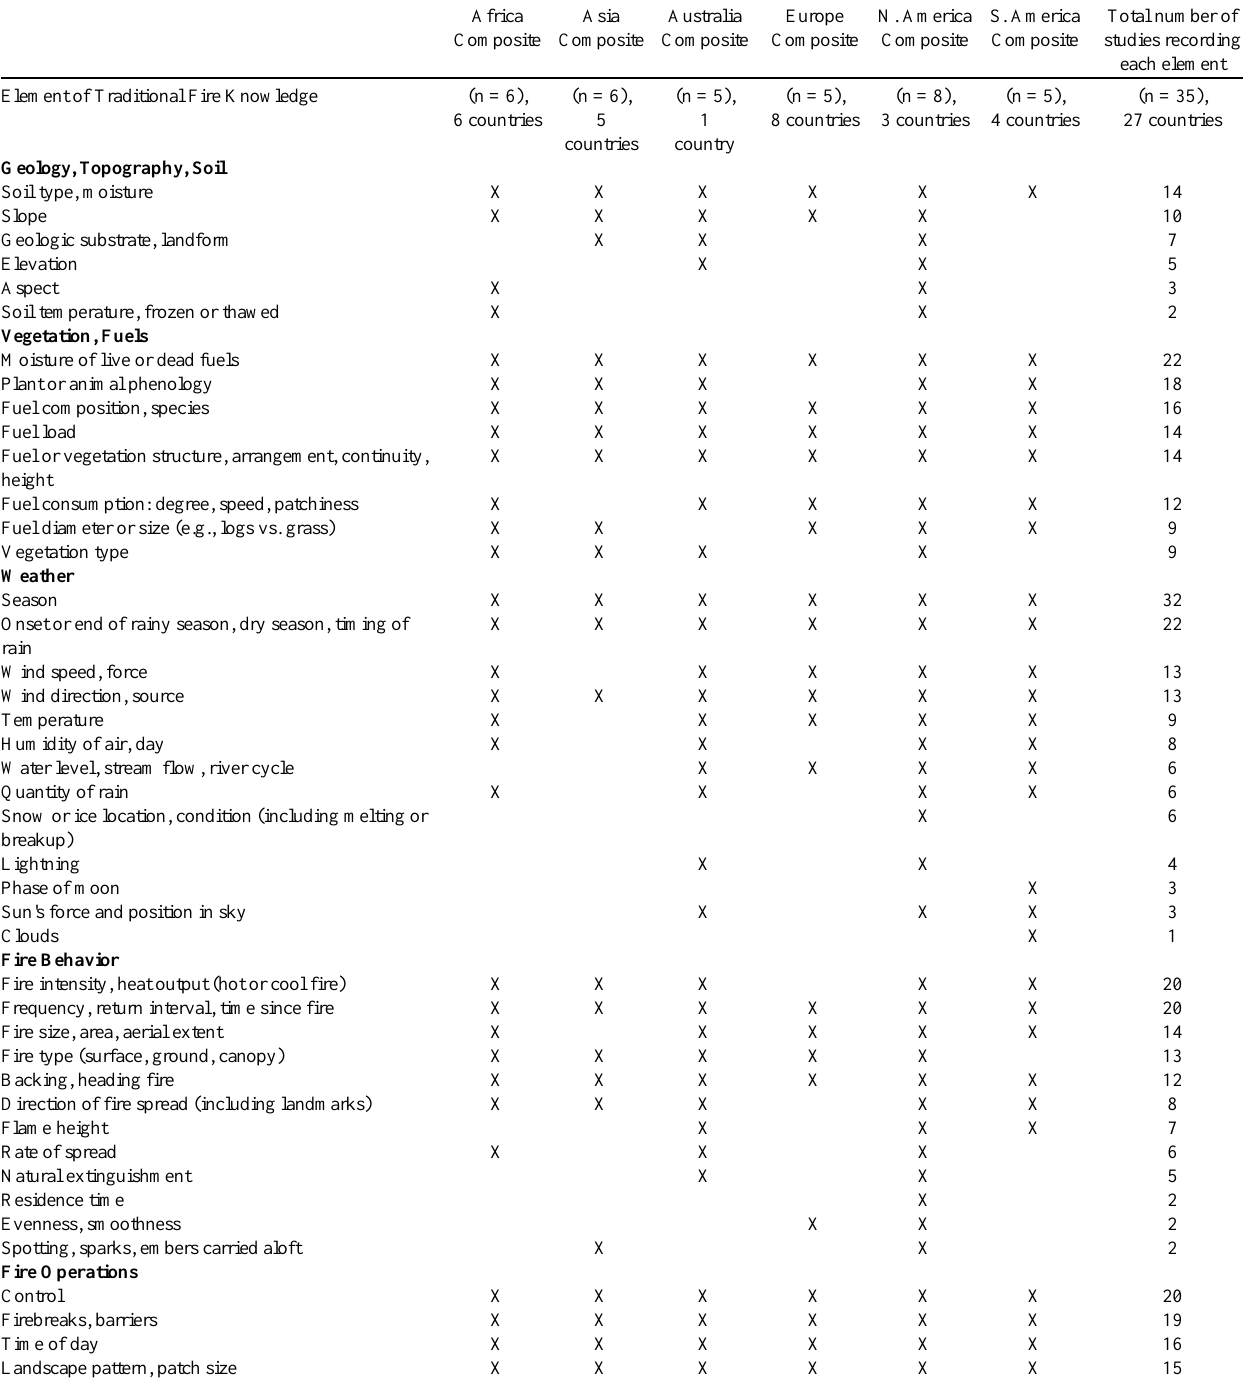
Table 1 . Summary by continent of the elements of traditional fire knowledge recorded in 35 studies that included accounts from 27